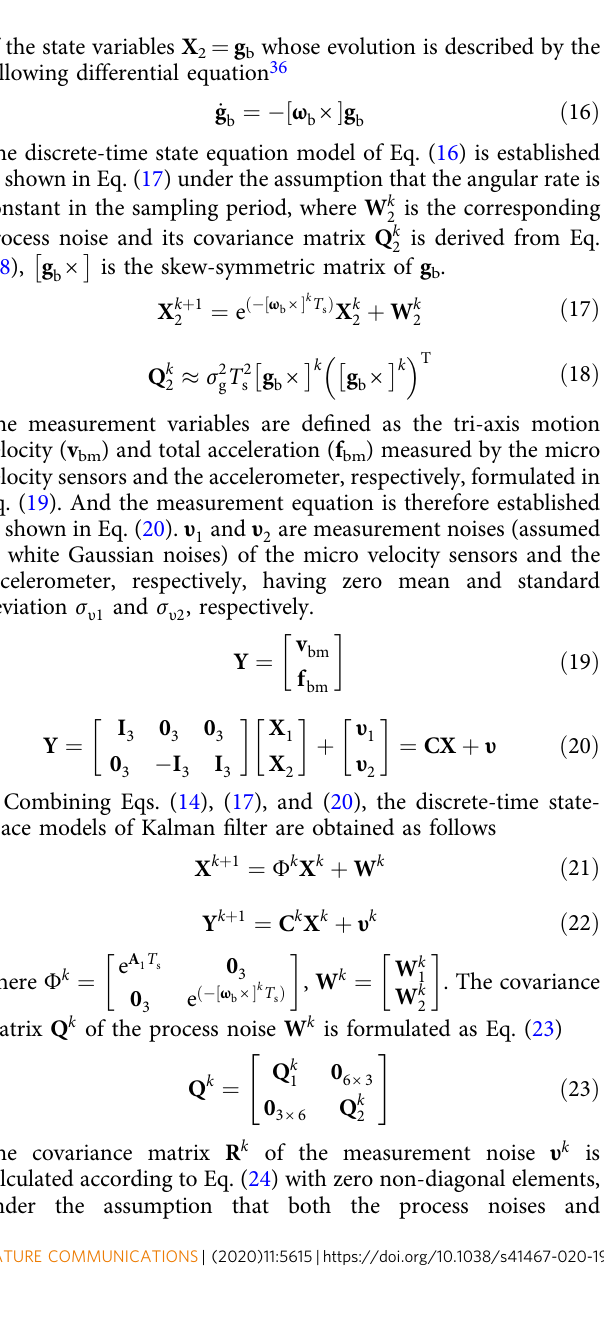
is the corresponding 2 is derived from Eq. 2